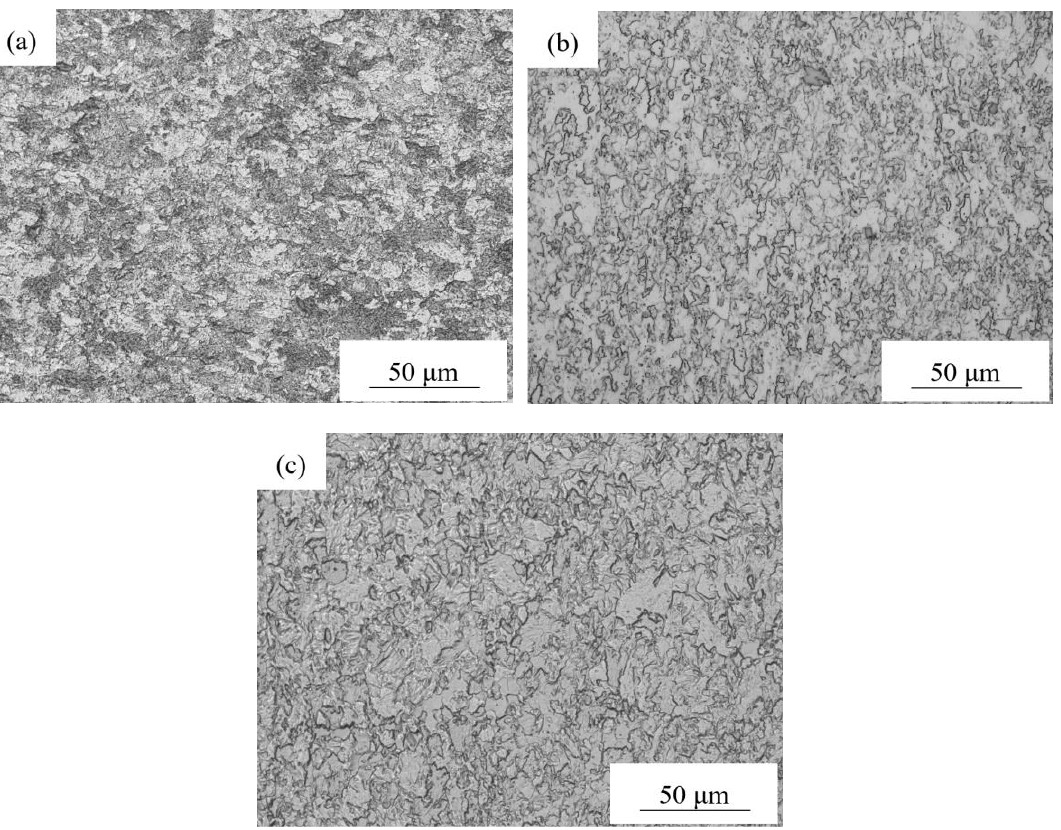
Figure 15. Optical micrographs of the low-carbon ferritic stainless steel samples with the different strain rates: ( a ) 0.01 s −1 , ( b ) 0.1 s −1 , ( c ) 1 s −1 .